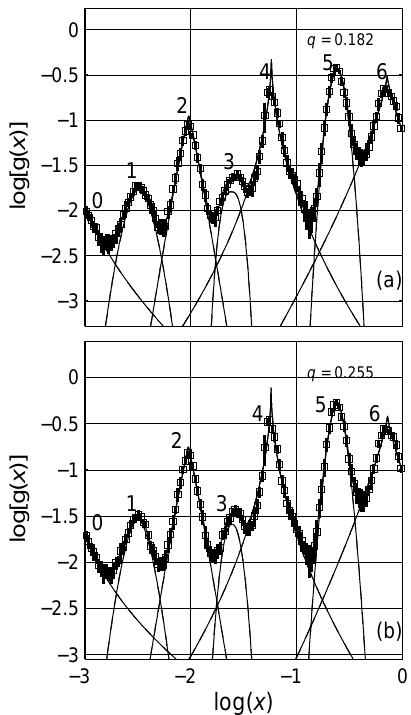
Figure 9 . Spectral density functions of the Landau-Lifshitz/Looyenga equation for two concentrations; (a) q = 0 . 2 and (b) q = 0 . 3 . The solid lines (——–) are L´evy distributions adapted to the estimated peaks. The numerical data is presented with symbol, error bars. The numbers on the peaks denote the significant peaks. Logarithmic scale is base